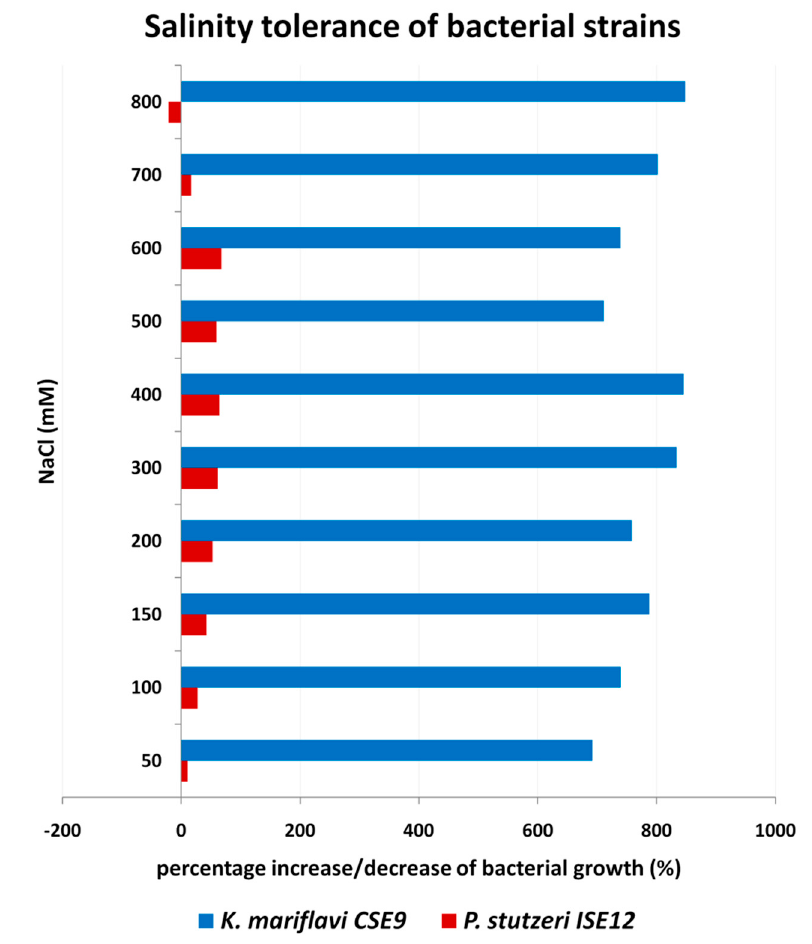
Figure 2. Growth of P. stutzeri ISE12 and K. marisflavi CSE9 in media supplemented with different NaCl concentrations (50-800 mM) was expressed as a percentage increase/decrease compared to concentrations (50-800 mM) was expressed as a percentage increase / decrease compared to bacterial bacterial growth in media without salt. growth in media without